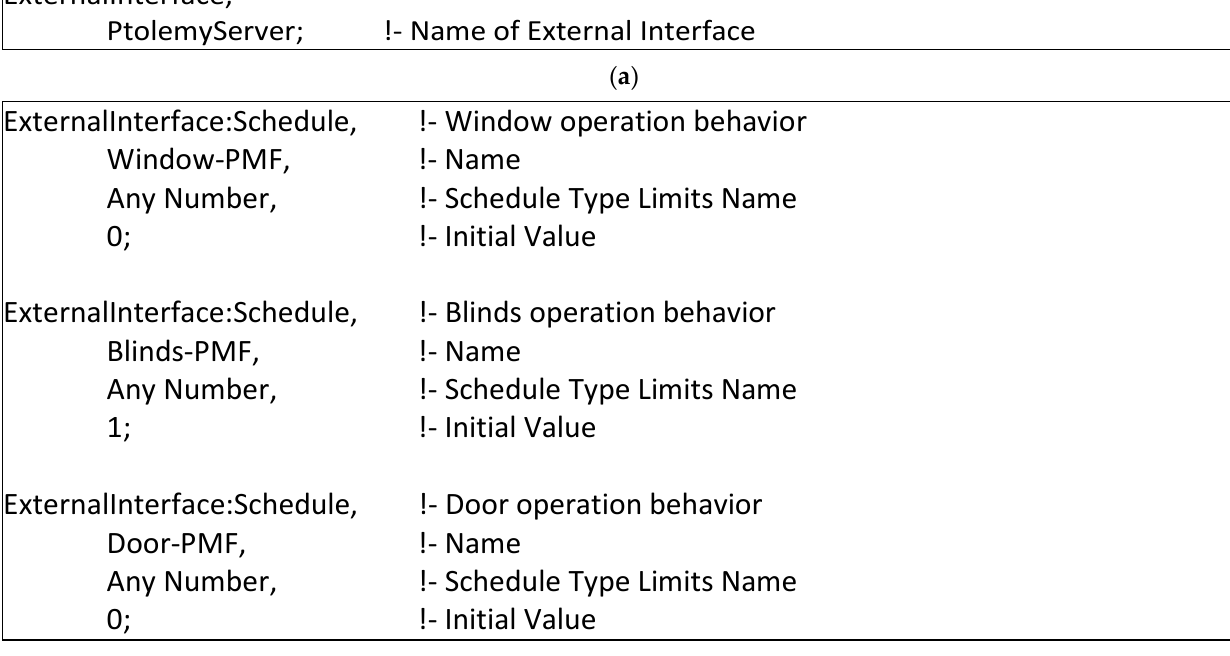
Figure 3. ( a ) External Interface activation in EnergyPlus™. ( b ). Schedule defining in External Interface for behavior update.